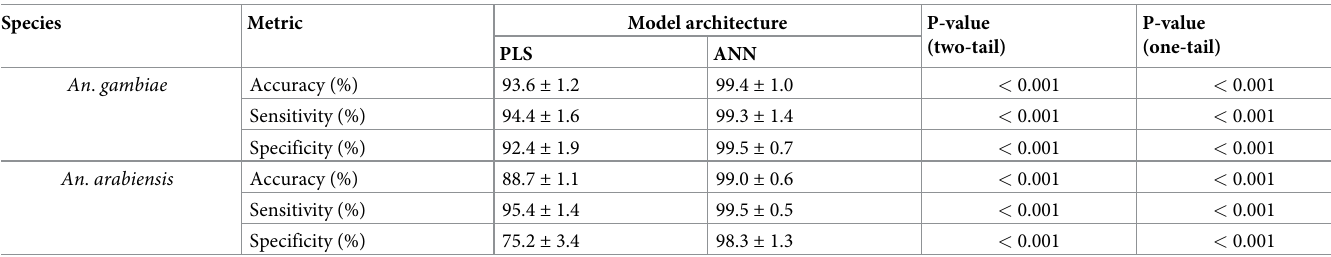
Table 3. Comparison of the accuracy of ANN and PLS classification models on ten